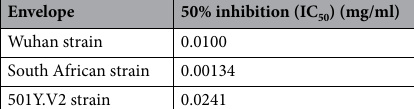
Table 3. IC 50 values of PHELA inhibition of different strains of SARS-CoV-2.